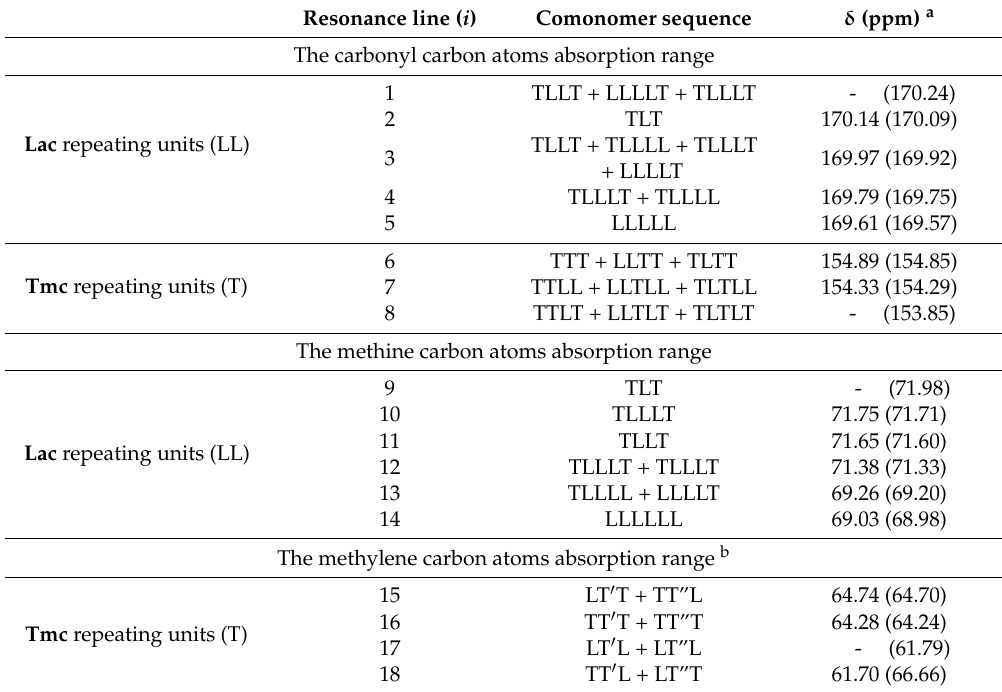
Table 1. Assignment of the resonance lines in the 13 C NMR spectra of Lac (composed of 2 lactic units denoted here as L: Lac = LL) and Tmc copolymer units in copolymers. Resonance line ( i ) Comonomer sequence δ (ppm)